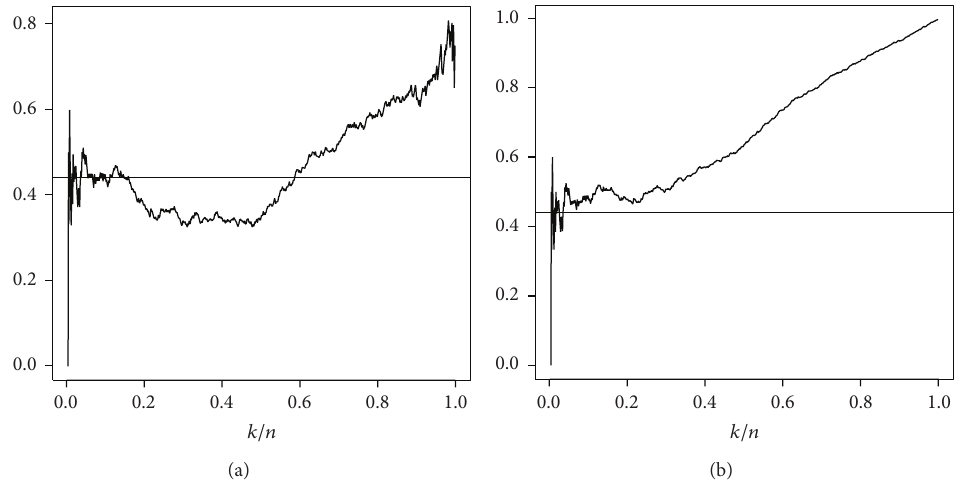
̂𝜆 LOG ̂𝜆 SEC (a) and estimator (b), plotted against 𝑘/𝑛 , 1 ≤ 𝑘 < 𝑛 , considering 𝑛 = 1000 realizations of a